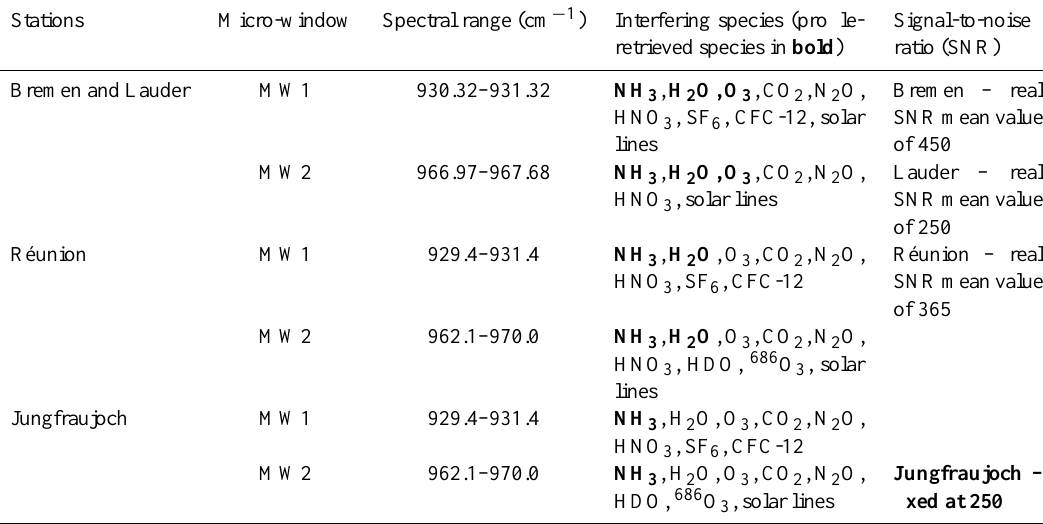
Table 2. Micro-windows used in the NH 3 retrieval at the four